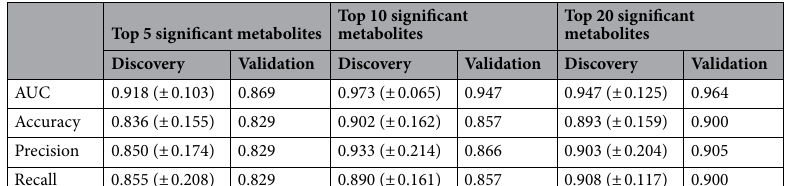
Top 10 significant